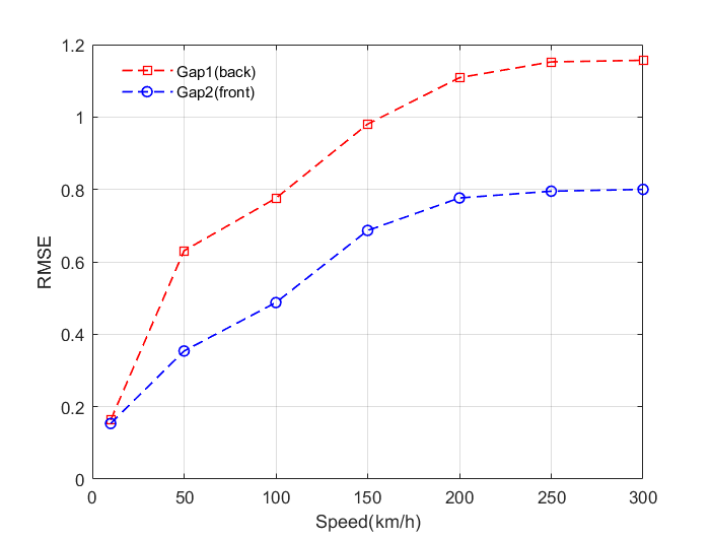
Figure 10. RMSE values of levitation gap errors vs. vehicle speed.